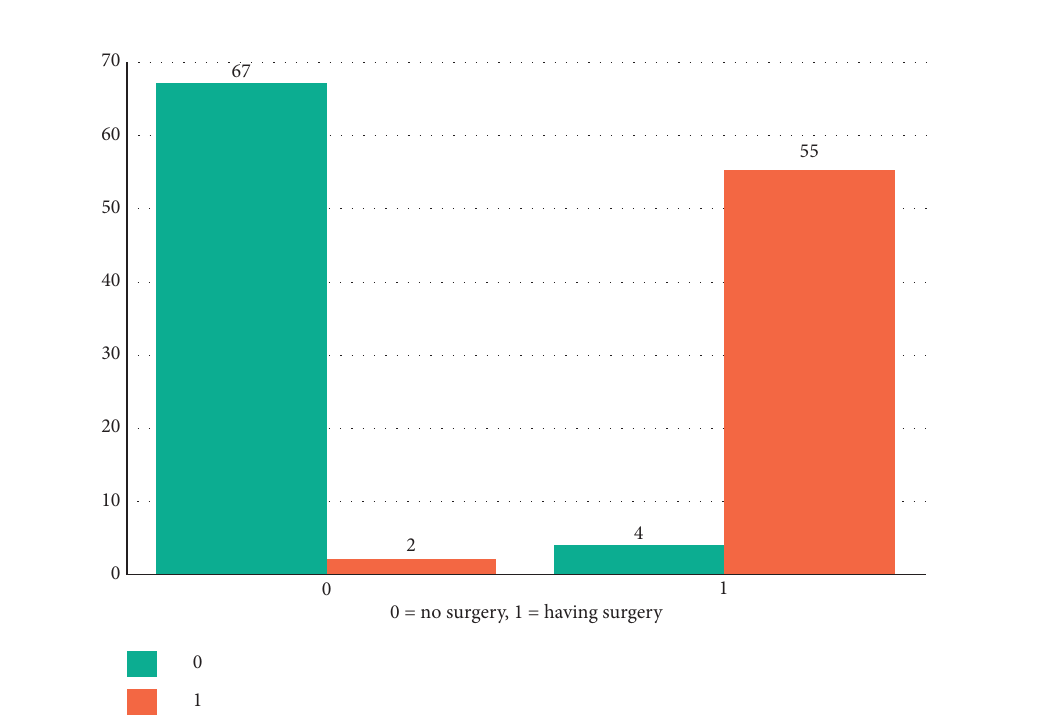
Figure 4: Gradient boosting tree